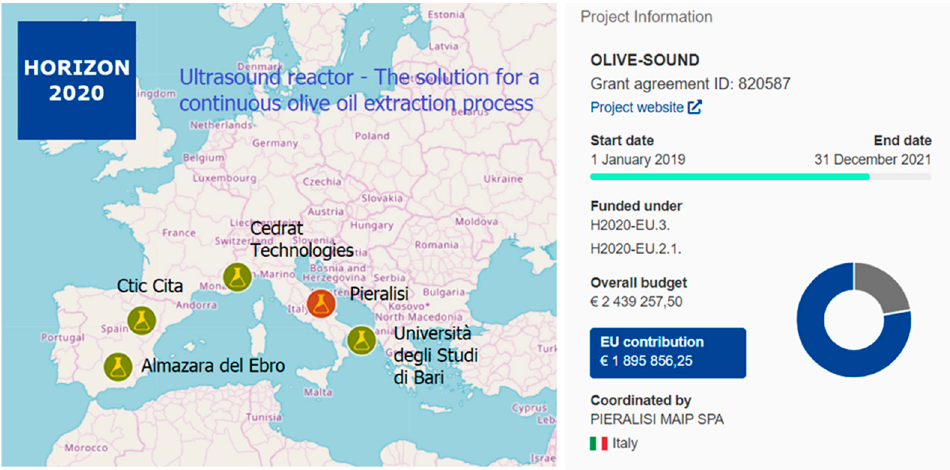
Figure 2. Composition of the partnership of the Horizon 2020 Olive Sound project.